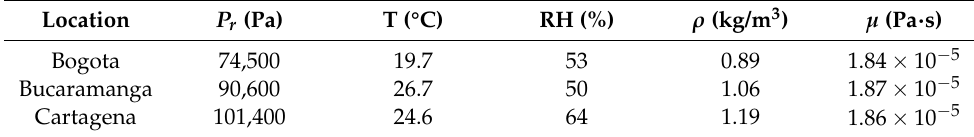
Table 1. Air properties for the different locations.